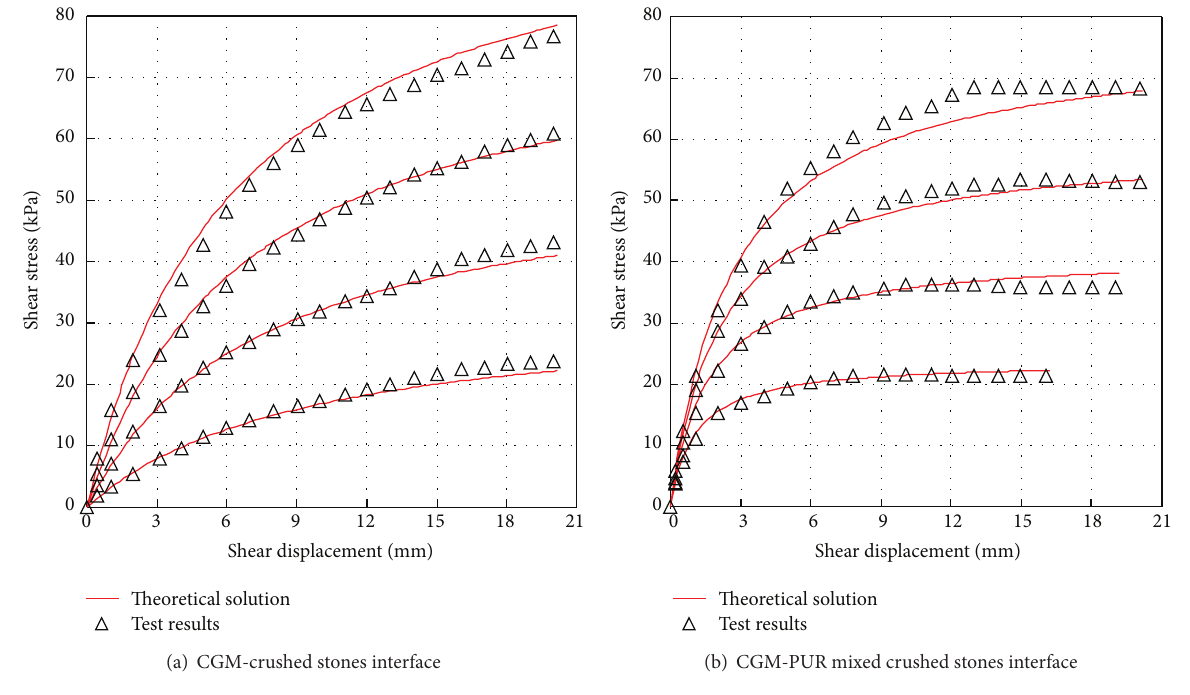
Figure 10: Comparison of test data with fitting curves of interface model.